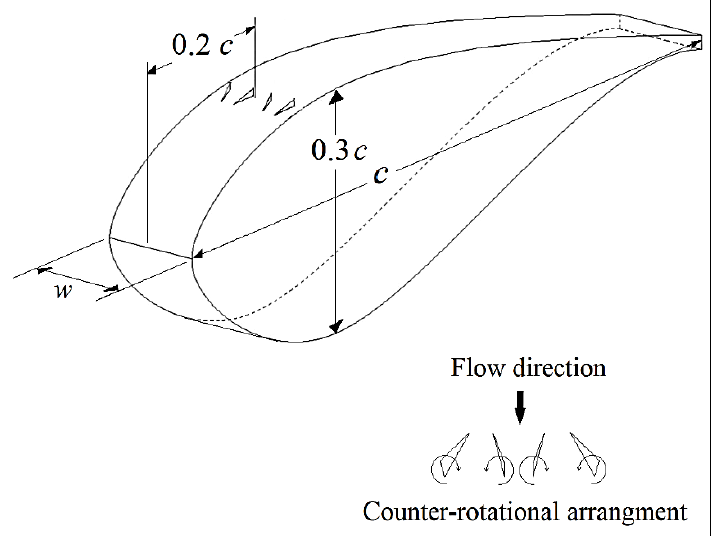
Figure 1. Blunt trailing-edge airfoil Du97-W-300 equipped with two pairs of counter-rotational